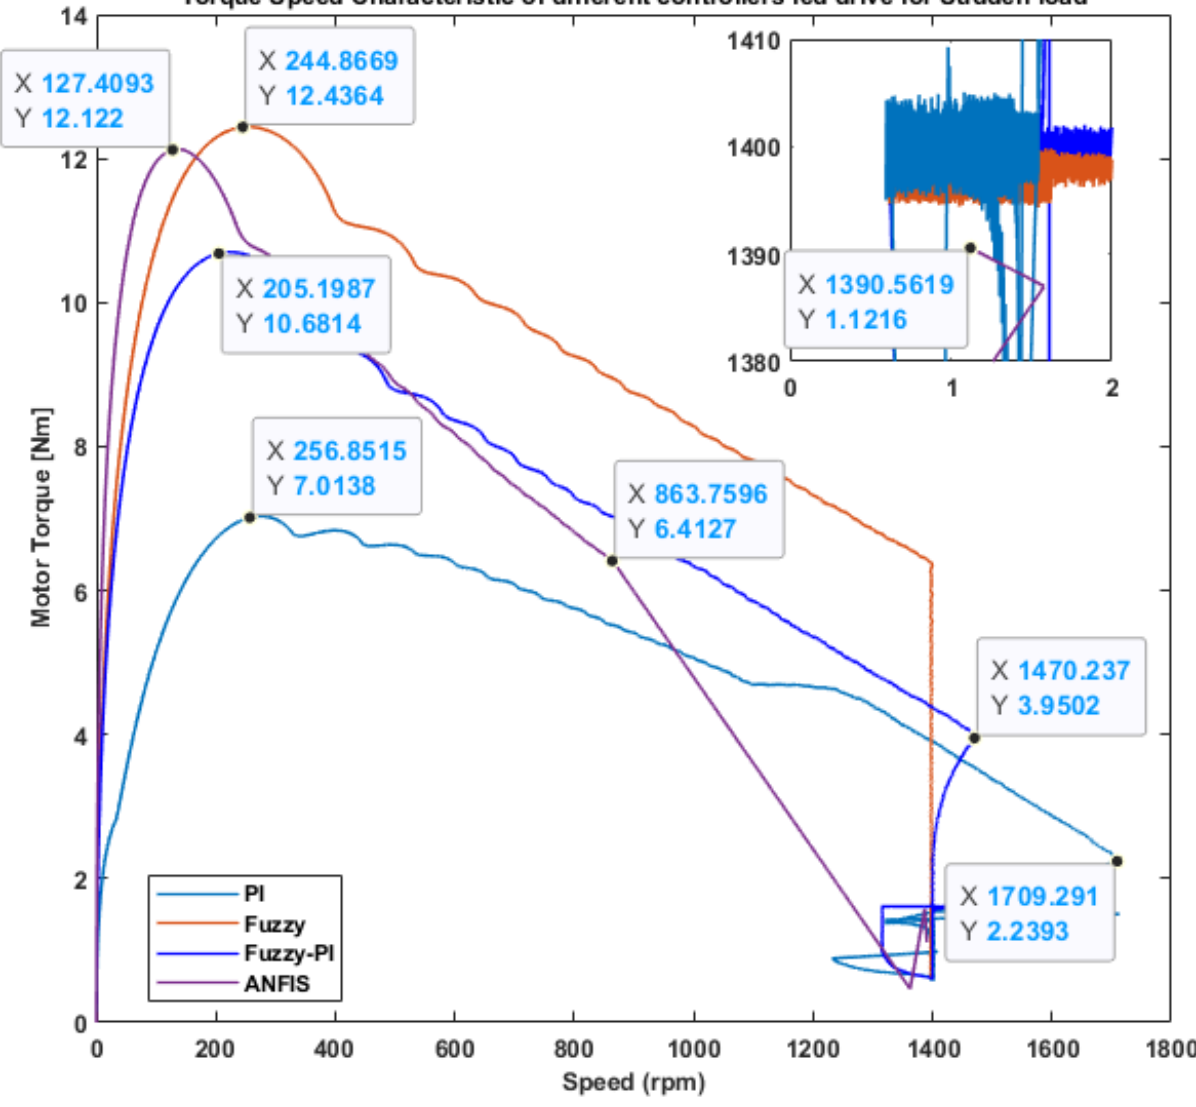
Figure 10. Speed torque characteristics with different controllers. Table 6. Speed torque comparison of different